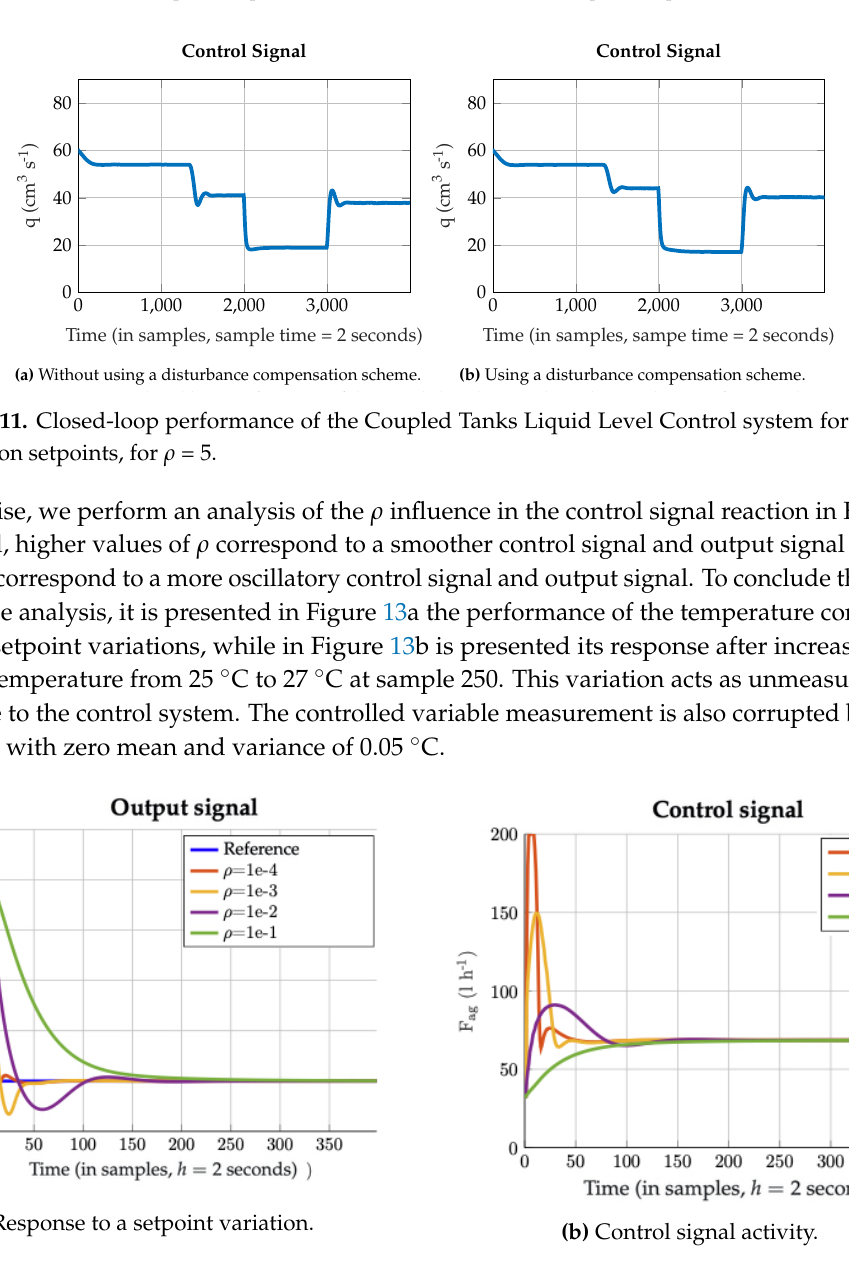
Figure 12. Influence of the parameter ρ (Control action attenuation factor) in the dynamic behavior of the control system.